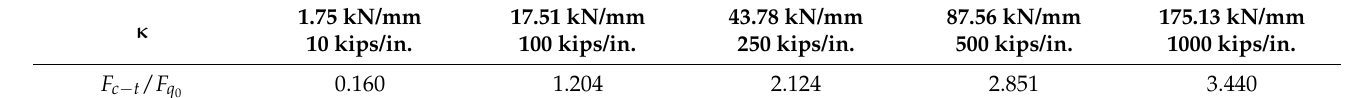
/𝐹 for various values of κ . (cid:3030)(cid:2879)(cid:3047) (cid:3044) (cid:3116) for various values of κ . 0